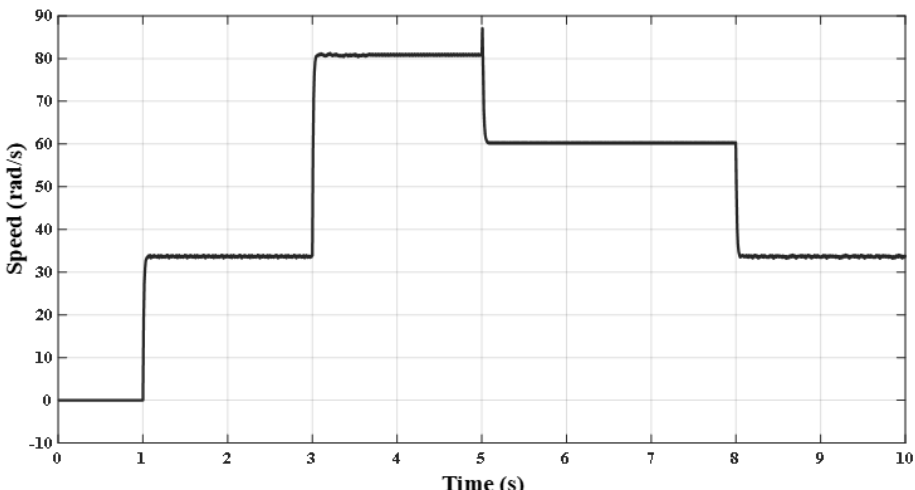
Figure 10. The DTSFC testbed for speed response behaviour with increased torque reference.